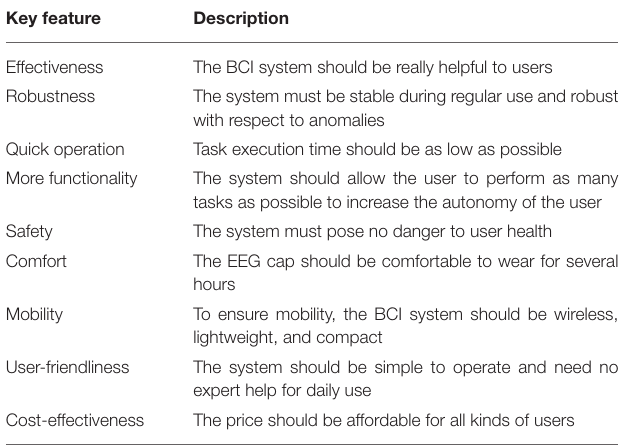
TABLE 11 | Essential features for BCI